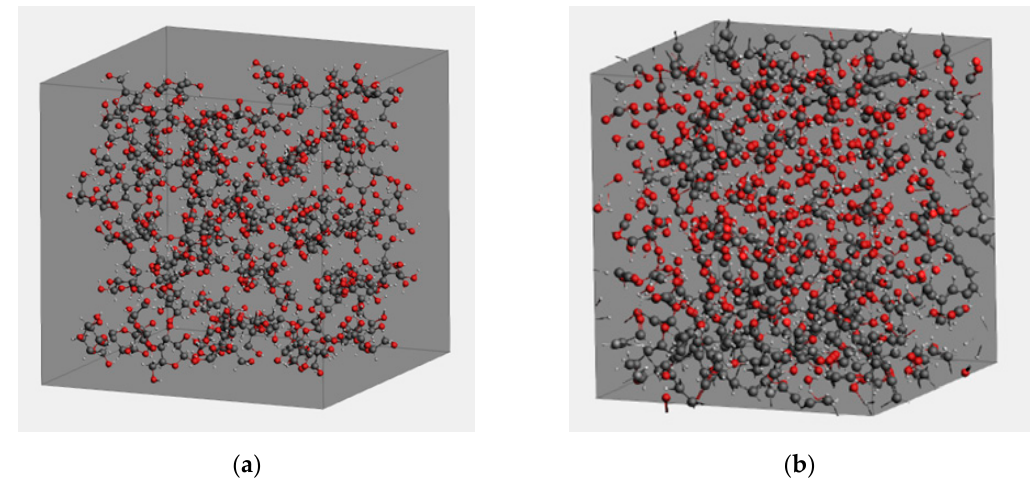
Figure 3. The energy minimization curve of cellobiose.